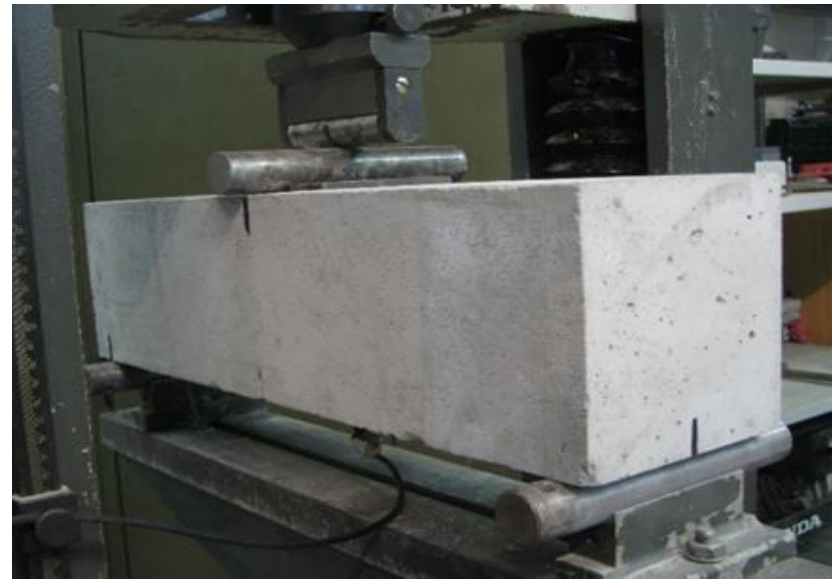
Figure 1. The concrete specimen in the CMOD test setup.